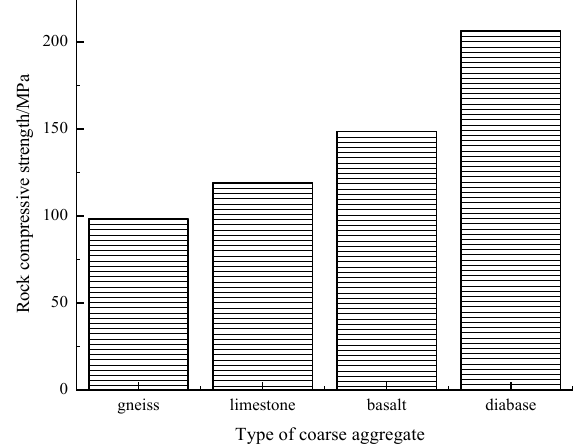
Figure 3. Compressive strength of the rock of a coarse aggregate.